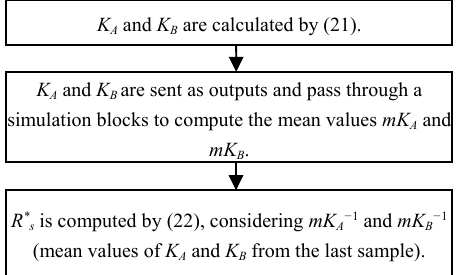
Figure 2. Modified stator resistance estimation—proposed direct method.